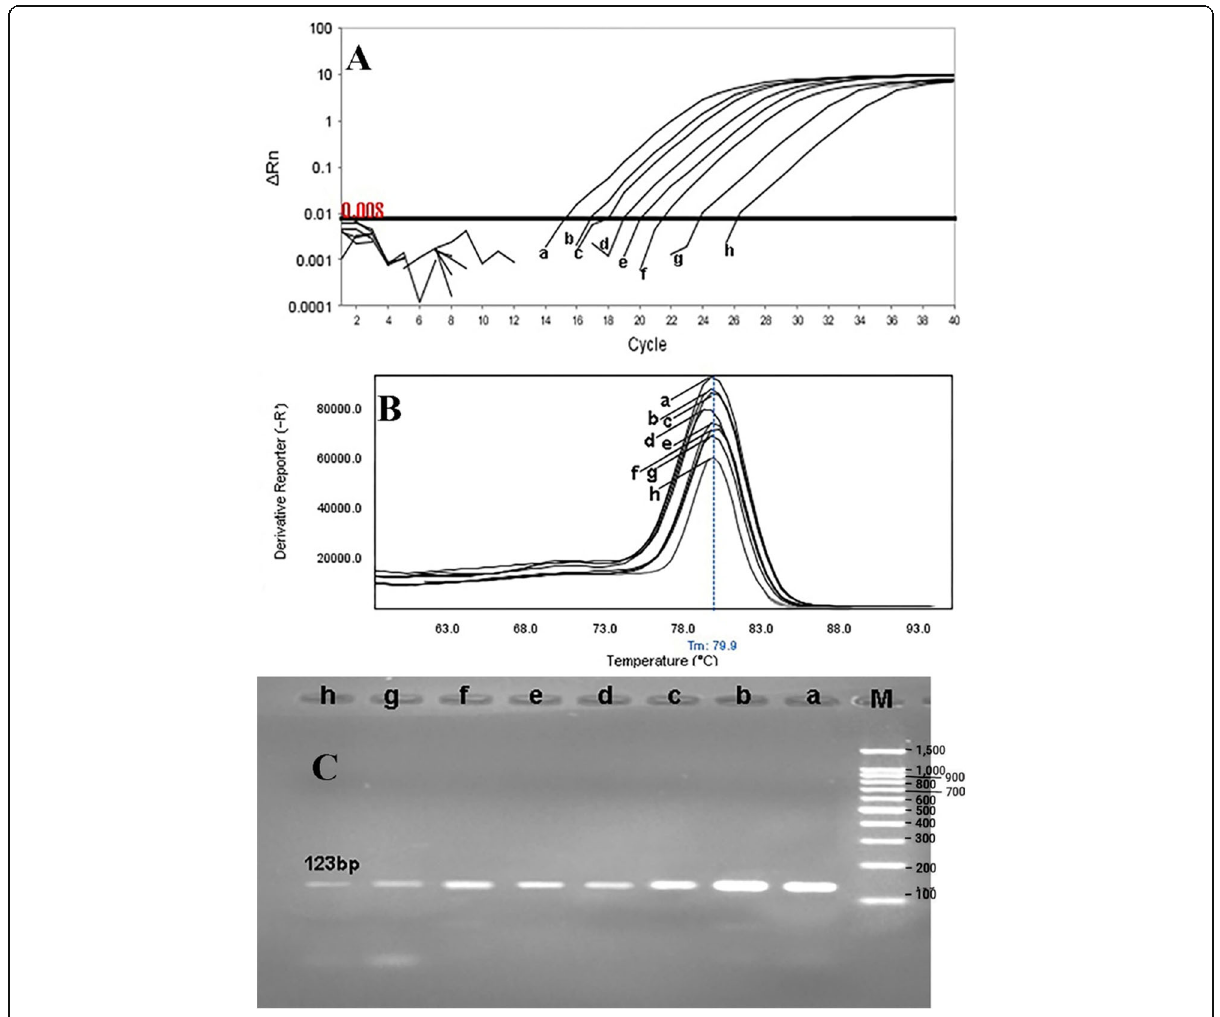
Fig. 1 Sensitivity of real-time PCR for primers used to detect of E. faecalis (divIVA gene) with a melting point of 79.9 ± 0.5 °C and amplification curve. E. faecalis NCTC13779 (as standard bacteria) with the concentration of 0.5 McFarland (1.5 × 10 8 CFU/ml) was provided into serial dilutions of 10 7 to 10 0 CFU/ml. a 10 7 , b 10 6 , c 10 5 , d 10 4 , e 10 3 , f 10 2 , g 10 1 , and h 10 0 . a Amplification curve, b Melting curve profile, and c corresponding agarose gel (1.5%) electrophoresis for real-time PCR amplification of divIVA gene. Horizontal lines represent cycle threshold of real-time PCR. One peak with a shoulder corresponds to genomic DNA amplification; no peak corresponds to no amplification. SYBR Green I color and single-tube reaction were used in this test. Also, real-time PCR was performed as single